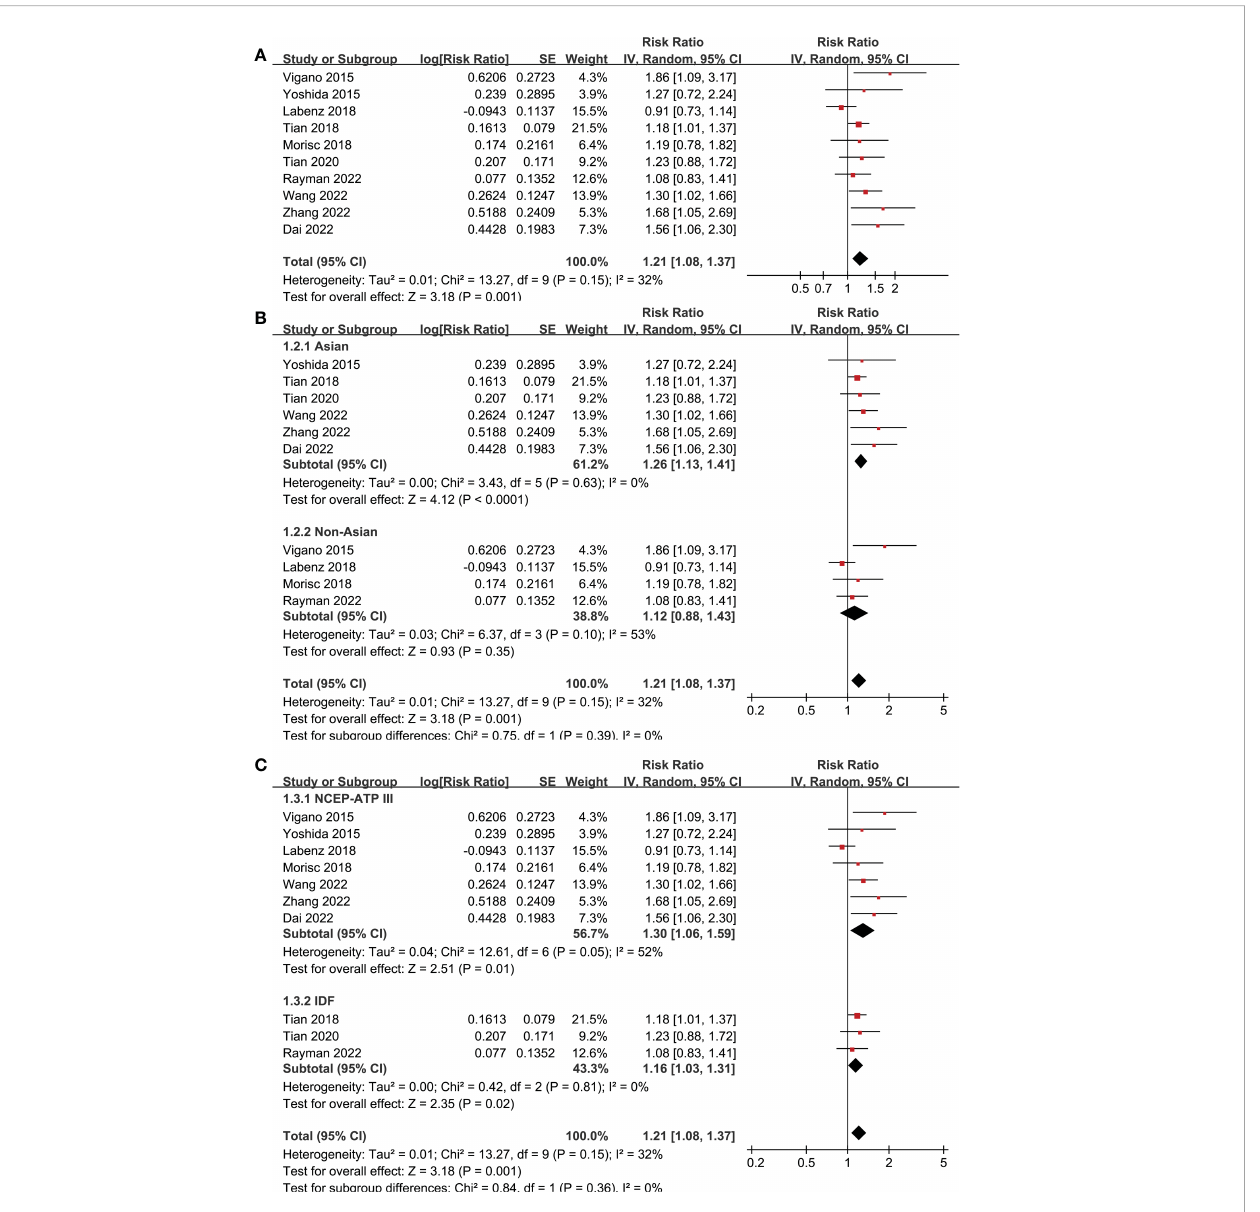
FIGURE 2 Forest plots for the meta-analyses regarding the association between MetS and OS in patients with HCC. (A) overall meta-analysis; (B) subgroup analysis according to the study country; and (C) subgroup analysis according to the diagnostic criteria for